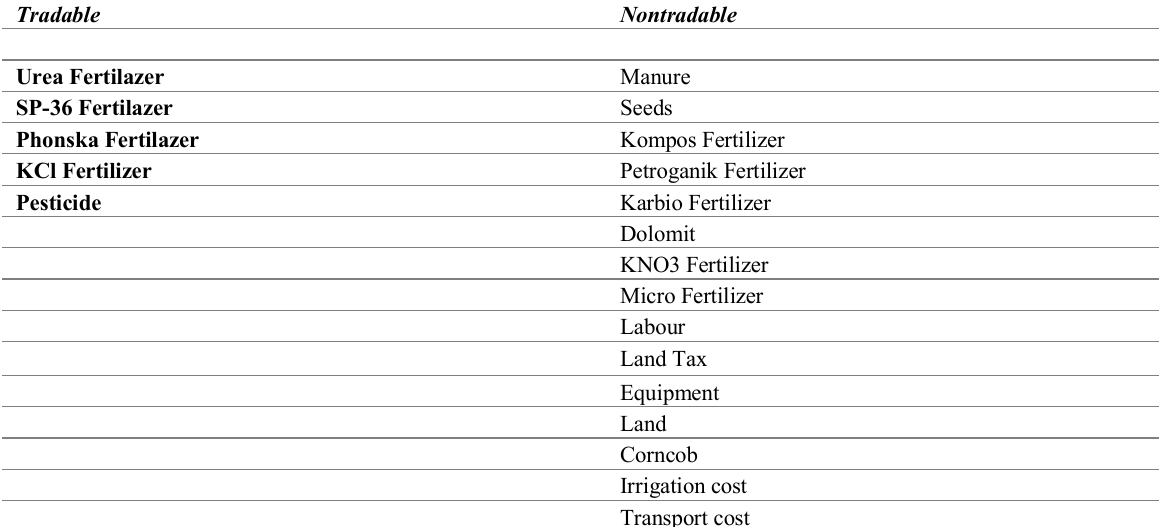
Table 3 : Determination of tradable and nontradable